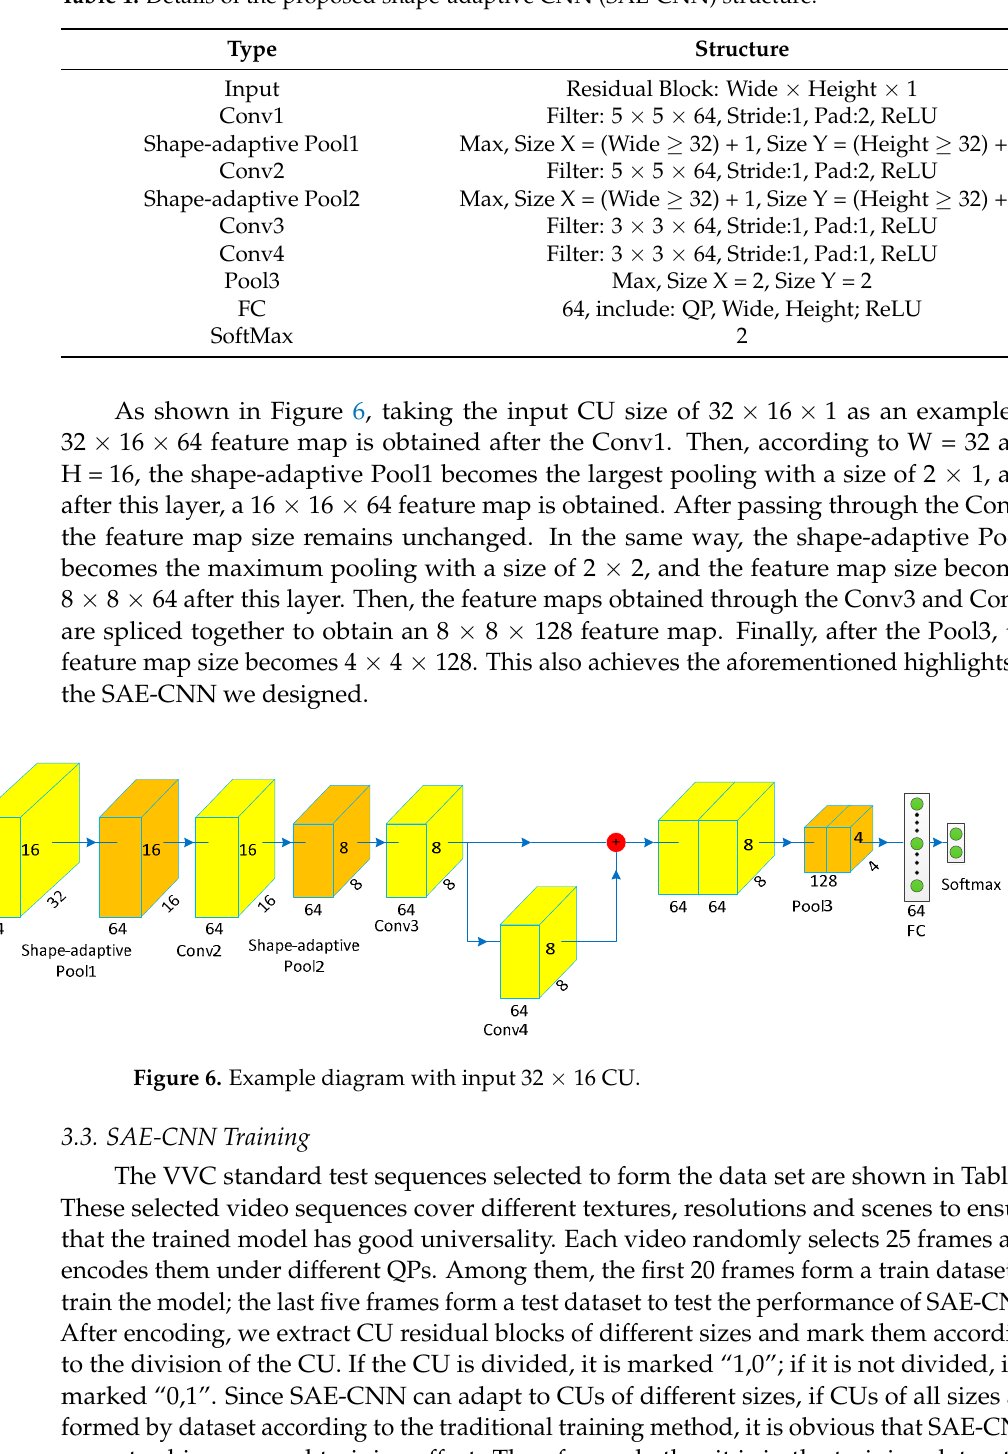
Table 1. Details of the proposed shape-adaptive CNN (SAE-CNN) structure.